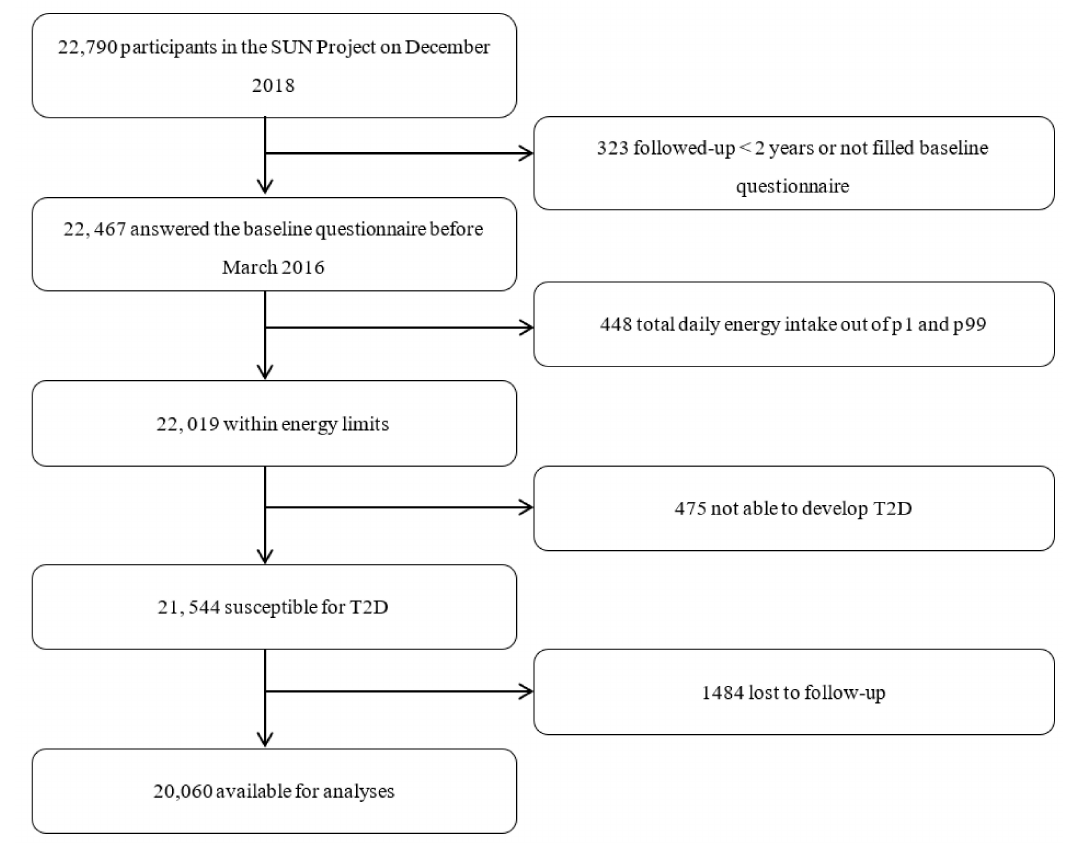
Figure 1. Flow chart of